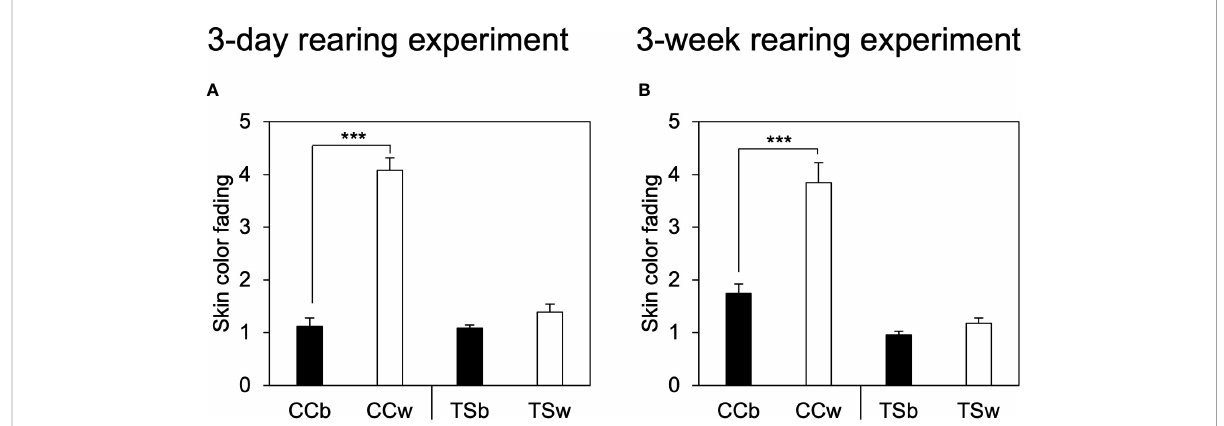
FIGURE 2 Effects of background color on skin color fading. Degree of skin color fading of common carp and Taisho-Sanshoku in the 3-day (A) and 3- week (B) rearing experiments. Data are shown as mean ± standard error (SE). Asterisks indicate statistically signi fi cant differences estimated using the Welch test (*** P < 0.001, n =